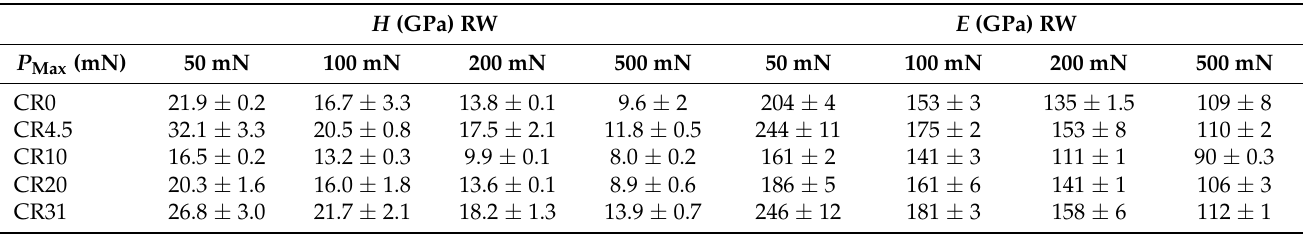
Table 2. H and E values of the RW plane in the as-cast and differently cold rolled samples at different maximum loads of 50 mN, 100 mN, 200 mN, and 500 mN. H (GPa) RW